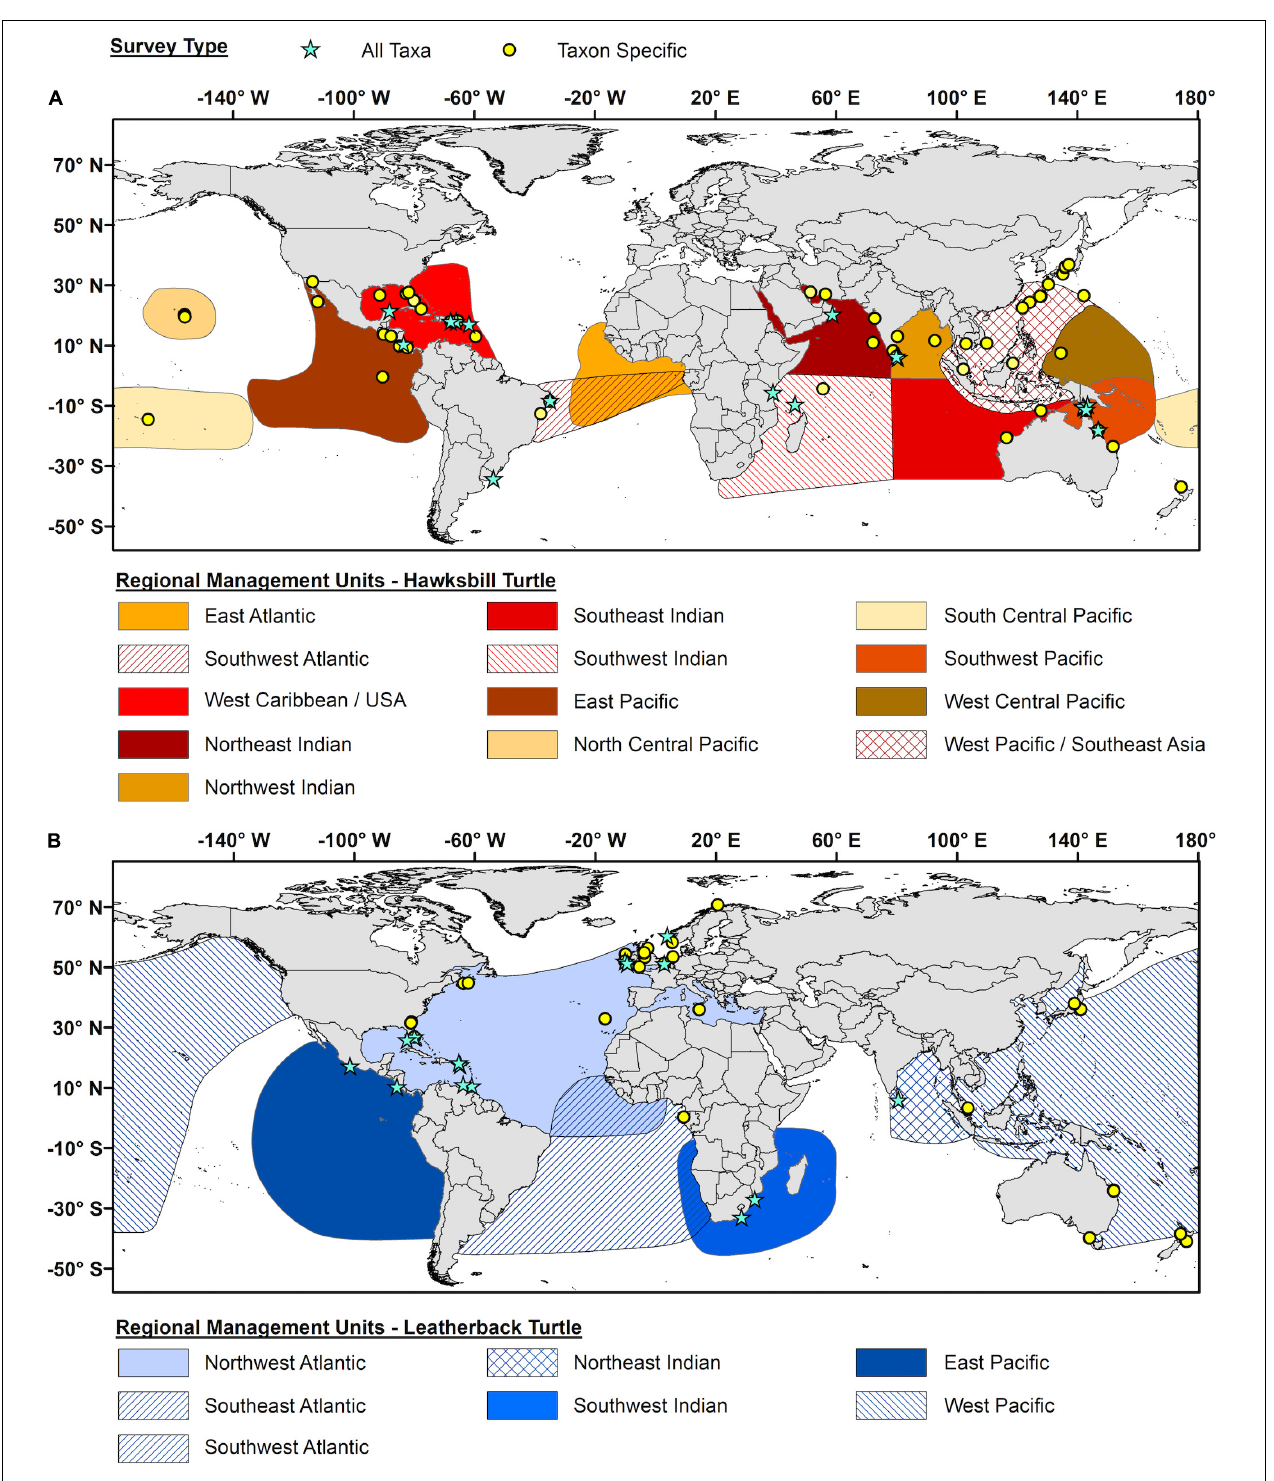
FIGURE 7 | Geographic distribution of all epibiont studies for (A) hawksbill turtles ( Eretmochelys imbricata ) and (B) leatherback turtles ( Dermochelys coriacea ). Blue stars represent studies that report on all potential taxa (All Taxa), while yellow circles represent studies that only focus on specific taxa (Taxa Specific). The geographic outlines for each Regional Management Unit as represented by differentially colored polygons (based on Wallace et al., 2010).